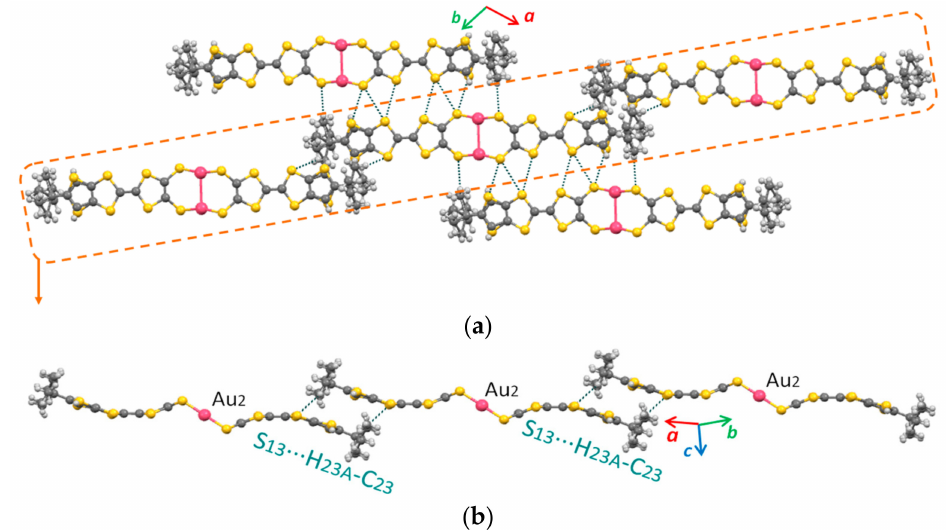
Figure 7. Anions Au2 in the crystal structure of ( n -Bu 4 N) 2 [Au 2 ( α -tbtdt) 2 ] ( 5 ): ( a ) View perpendicular to one anionic layer with side-by-side contacts; ( b ) view perpendicular to anionic